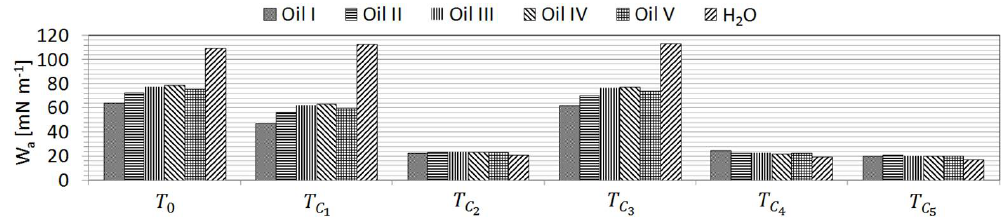
Figure 9. Calculated work of adhesion W a between the treated textiles and the functional fluids.